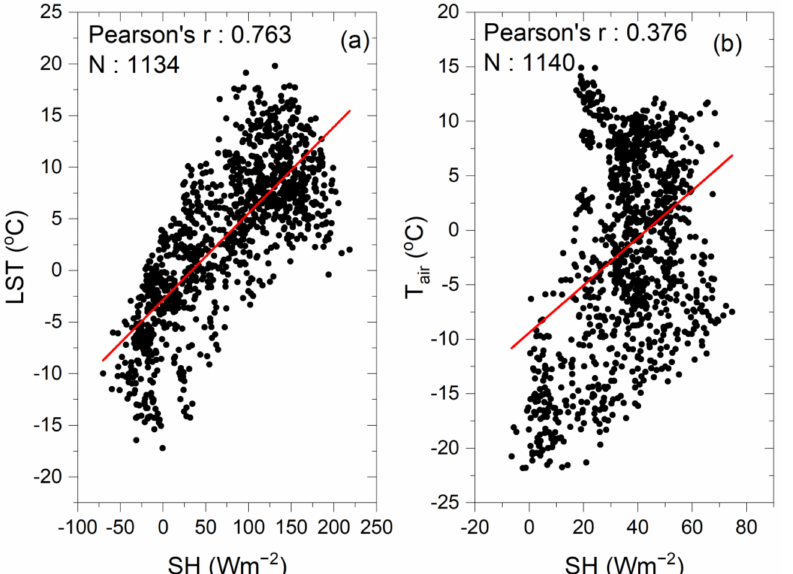
Figure 9. Correlation between ( a ) LST obtained from MODIS product and satellite SH. Random pixels were selected from mean monthly images of both parameters; a significant r-value shows the strong correlation between both parameters. ( b ) Air temperature at 2 m obtained from ERA5 and ERA5 SH. Below-average r-value exhibits that these factors are not closely related to each